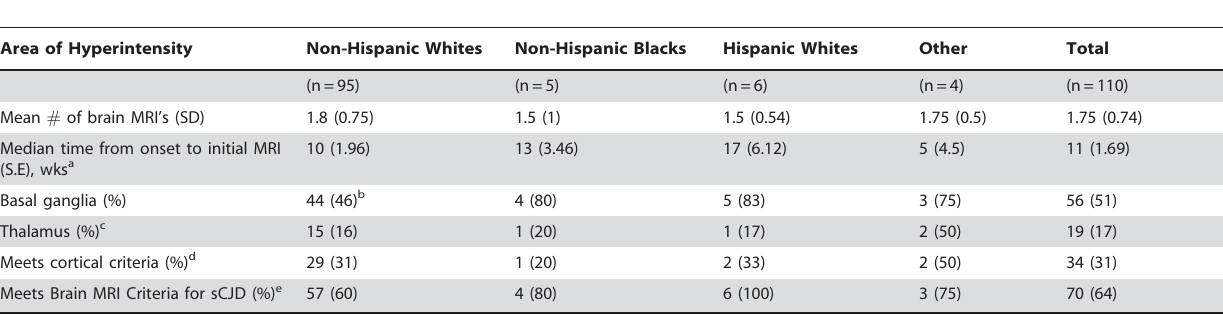
Brain MRI was not done for 2 subjects and results were unknown in 4 subjects. a imes could not be calculated for 7 subjects. b p , 0.05. c 13/15 cases also had basal ganglia hyperintensity.